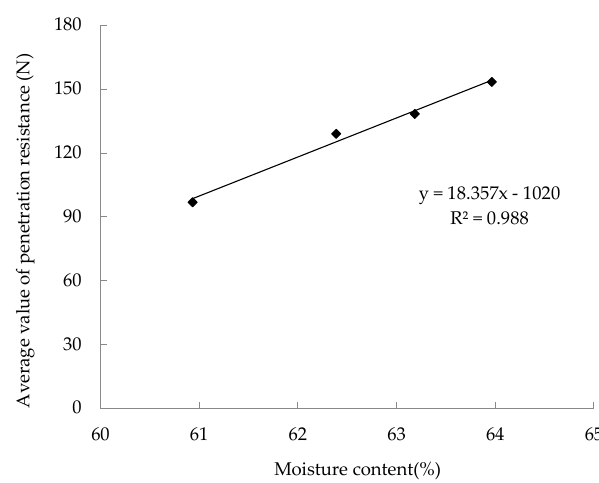
Figure 10. Average value of penetration resistance of silages with two different moisture contents.